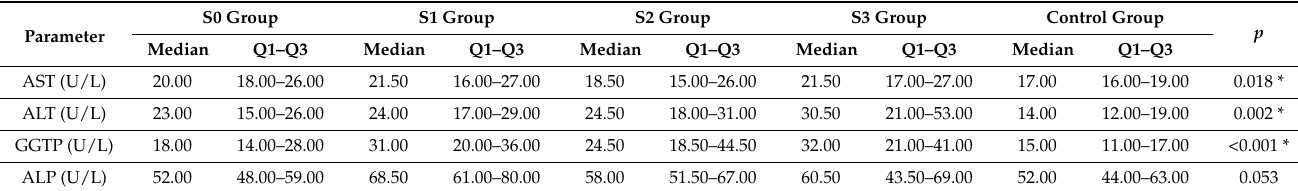
Figure 2. Correlations between the CAP and BMI, total body fat, VAT area in the transverse section of the abdomen, and the VAT/SAT ratio. Table 4. Characteristics of the hepatic laboratory parameters of all